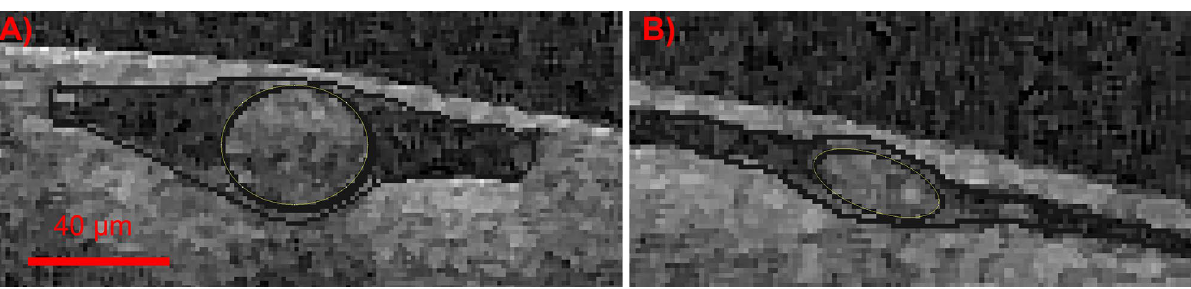
Figure 2. Blood vessels were imaged with optical coherence tomography (OCT). In vivo OCT images were taken from the surface of a human brain, after craniotomy. CSF appears as dark signal, and is present in the perivascular spaces (PVS) surrounding the blood vessels and the subarachnoid space (SAS). PVS and SAS appear to be continuous. These images were used to create image-based geometries for the artery ( A ) and the vein ( B ). Geometries were scaled to mouse size to be comparable to experimental data. Scale bar indicates dimensions after